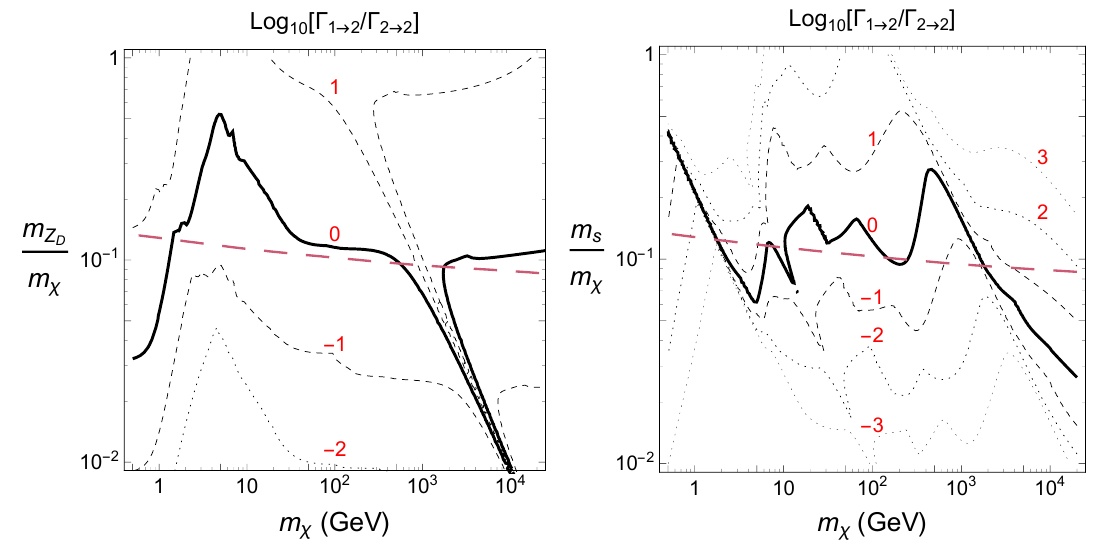
Figure 12 . Contours showing the ratio of 1 $ 2 to 2 $ 2 scattering rates in our minimal models. In regions below the pink dashed line, the dark mediator furnishes a radiation bath at the time of DM freezeout. In the region where (cid:0) 1 $ 2 & (cid:0) 2 $ 2 , the true value of (cid:15) min ( T eq ) is lower than the value we quote from 2 $ 2 processes alone. Left: HSFO-VP. For dark vector masses near the Z -pole, the 1 $ 2 grows very large. Right: